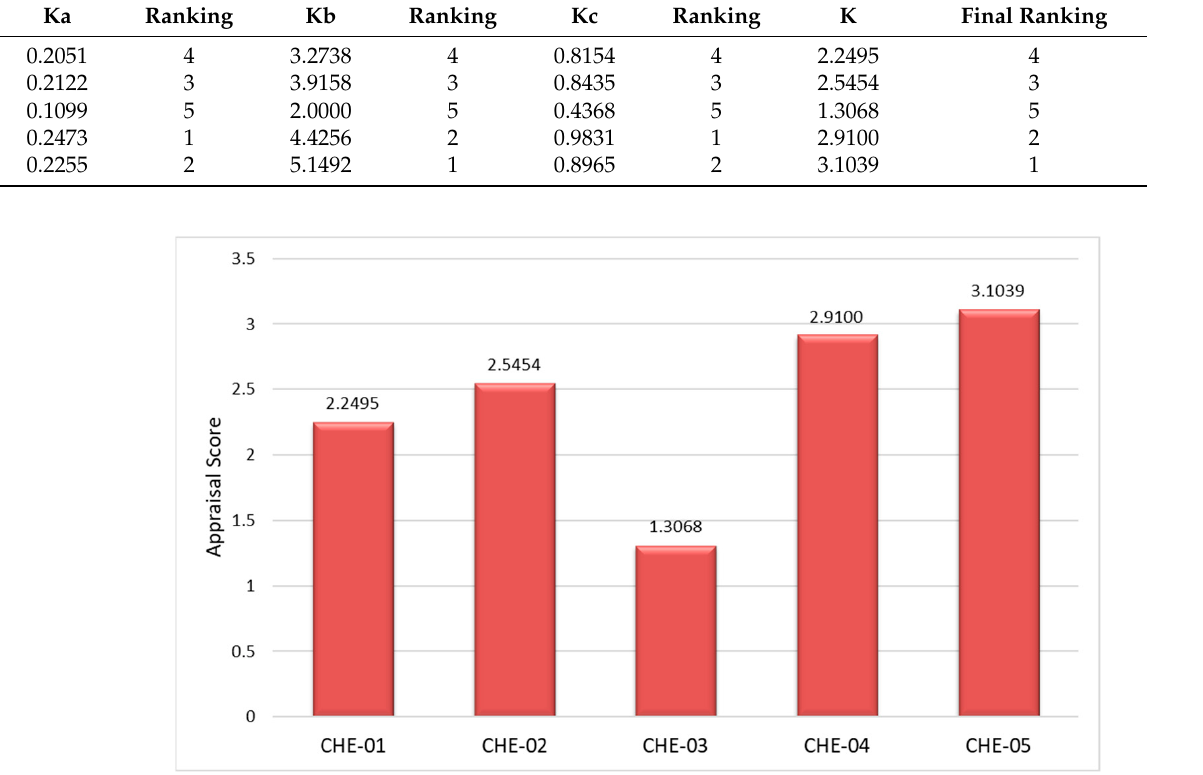
Figure 4. Final ranking of suppliers.